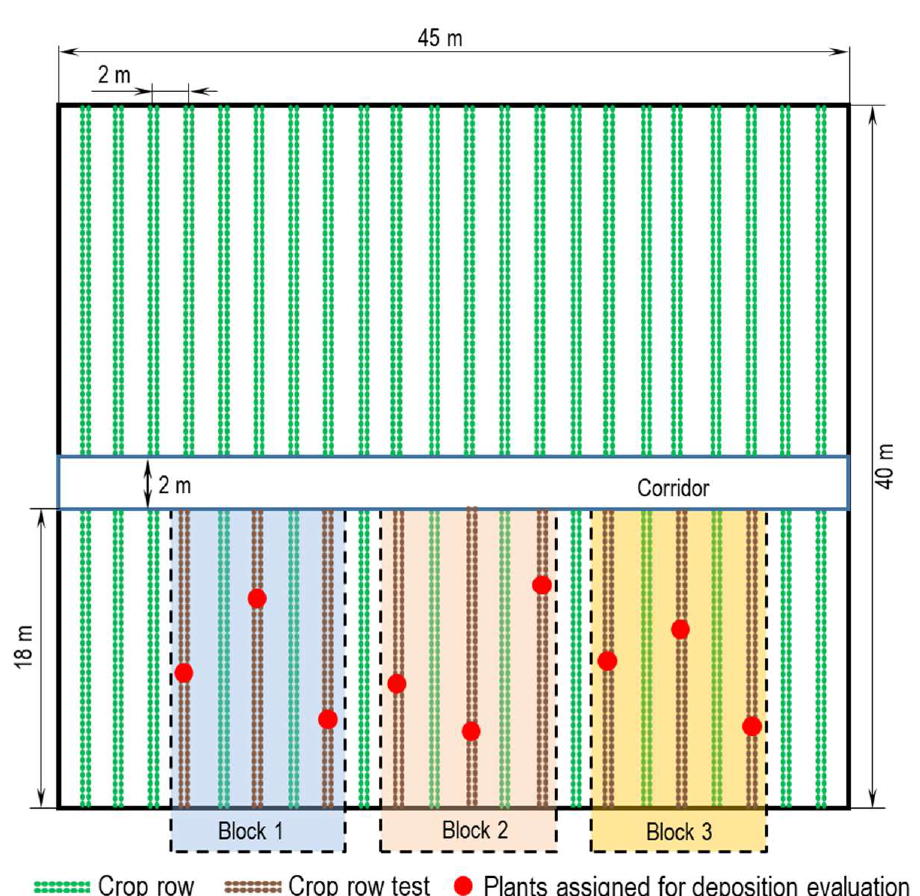
Figure 3. Distribution of the test blocks and location of the sampling areas. In each block, 3 sprayings were applied, one for each of the devices in a different randomly assigned test line. In each test line, a pair of plants was selected at random from which samples were taken (the leaves) in 8 different zones (Figure 4), at 4 depths (D1, D2, D3 and D4), and 2 heights (H1 and H2). Additionally, in each area, artificial collectors were placed on the underside of the leaves. Collectors were also placed on the ground, 2 coinciding with the outer planes of the crop lines and another in the central zone between the pair of plants (Figure 4). Therefore, a total of 243 samples were taken ((12 zones × 2 [leaves and underside] + 3 soil samples) × 9 pairs of plants). The artificial collectors placed both on the underside of the leaves and on the ground consisted of 3 × 8 cm filter paper strips (Filter-Lab Ref. 1238, Filtros Anoia, S.A., Barcelona). In all the applications, the lines were sprayed on both sides, following the usual practice of operators in the